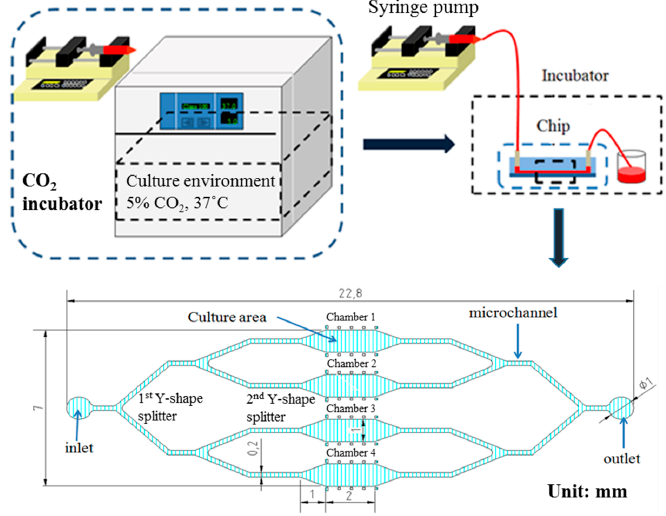
Figure 2. Schematic illustration of rBMSCs fluid flow stimulation microchannel design and experimental setup.